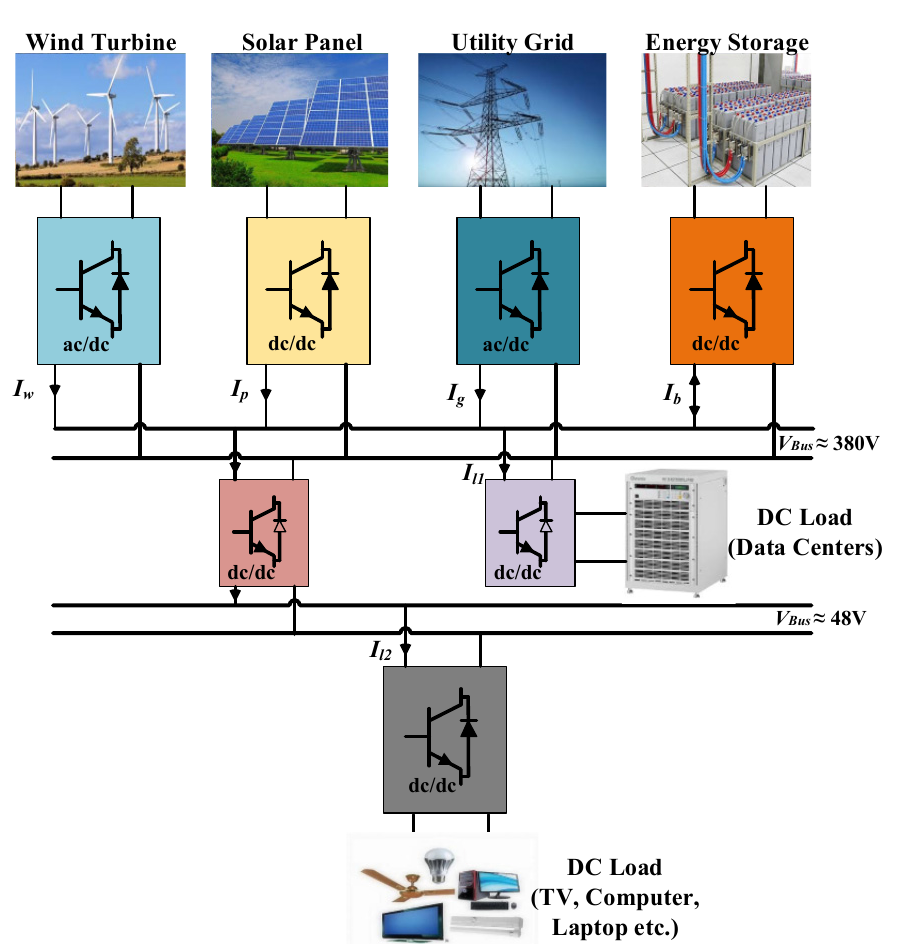
Figure 1. Configuration of direct current (dc) nanogrid based distributed energy system (DES) for future residential applications [20].